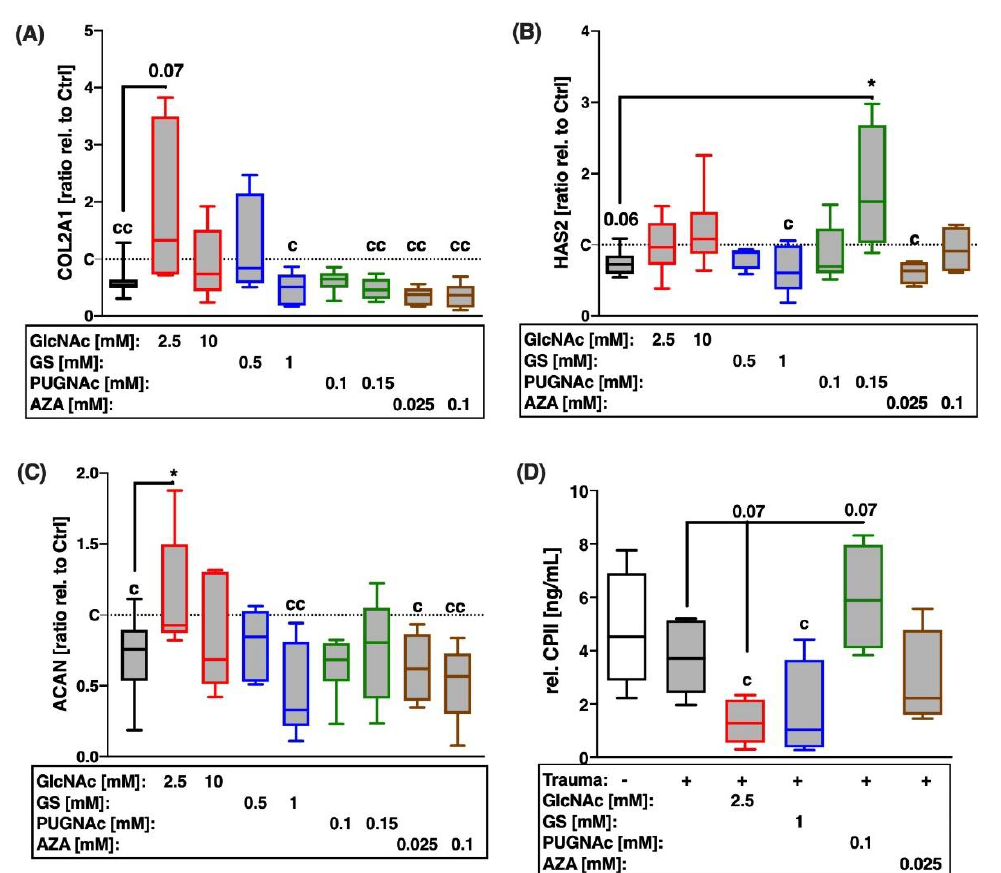
Figure 4. Effects of glucosamine, PUGNAc, and AZA on chondroanabolic processes 7 days after cartilage trauma. Chon- droanabolism was evaluated by means of gene expression analysis of ( A ) COL2A1, ( B ) HAS2, and ( C ) ACAN, as well as by ( D ) quantification of CPII release. Statistical analysis: ( A , B ) Kruskal–Wallis test, ( C , D ) one-way ANOVA. Significant differences between groups were depicted as: [versus T] * = p < 0.05; [versus C] c = p < 0.05, cc = p < 0.01; all data sets n ≥ 5. Blank box = unimpacted control (C), shaded boxes = traumatized cartilage explants (T).